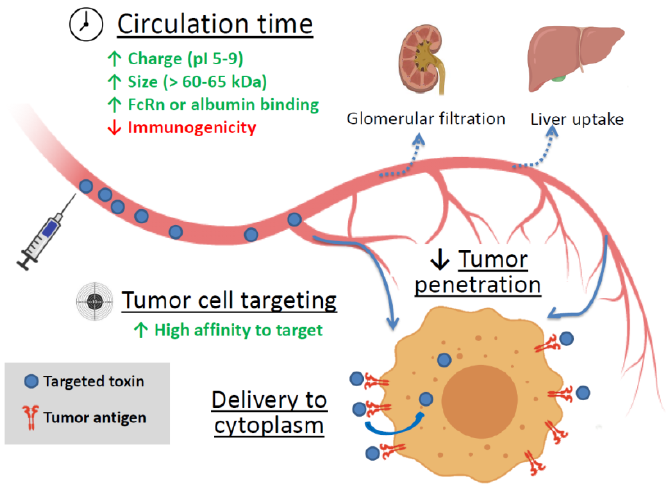
Figure 1. The main factors affecting the efficiency of targeted toxin. Green up arrows—factors enhancing circulation time and tumor cell targeting. Red down arrow—reducing factor. FcRn is the neonatal Fc receptor.